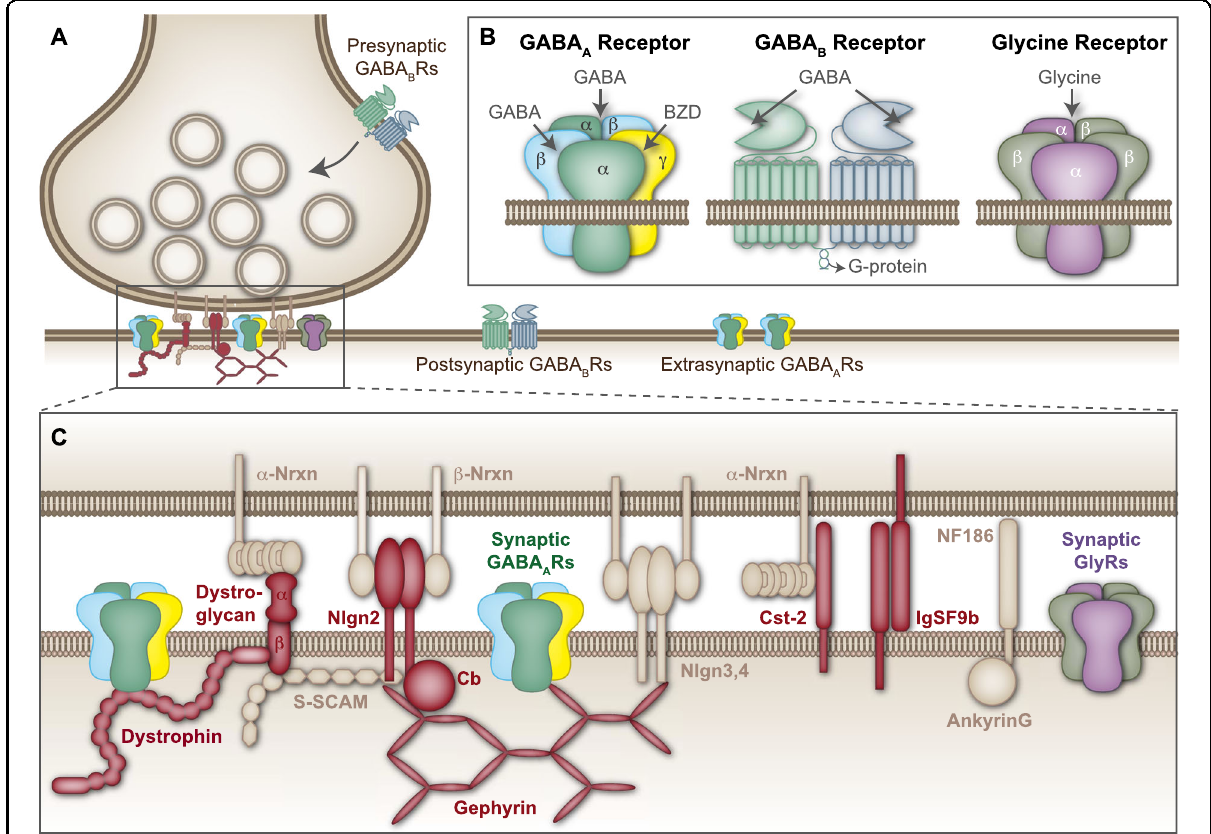
Fig. 2 Molecular determinants of anxiety-related behavior at inhibitory synapses. a Overview of the synaptic and extrasynaptic machinery involved in mediating and regulating inhibitory neurotransmission. b Receptors that have been linked to mediating inhibitory neurotransmission in the amygdala anxiety circuitry. c Molecular components of the inhibitory postsynapse (adapted from ref 2 ). Components depicted in red represent synapse organizers that have been linked to exaggerated anxiety behaviors in humans and/or mice. Components depicted in beige represent synapse organizers that are known to be present at inhibitory synapses, but have not been linked to anxiety. Not all known inhibitory synapse organizers are depicted here; a complete list is available in refs 2,3 . Abbreviations: BZD benzodiazepine; Cb collybistin; Cst-2 calsyntenin-2;